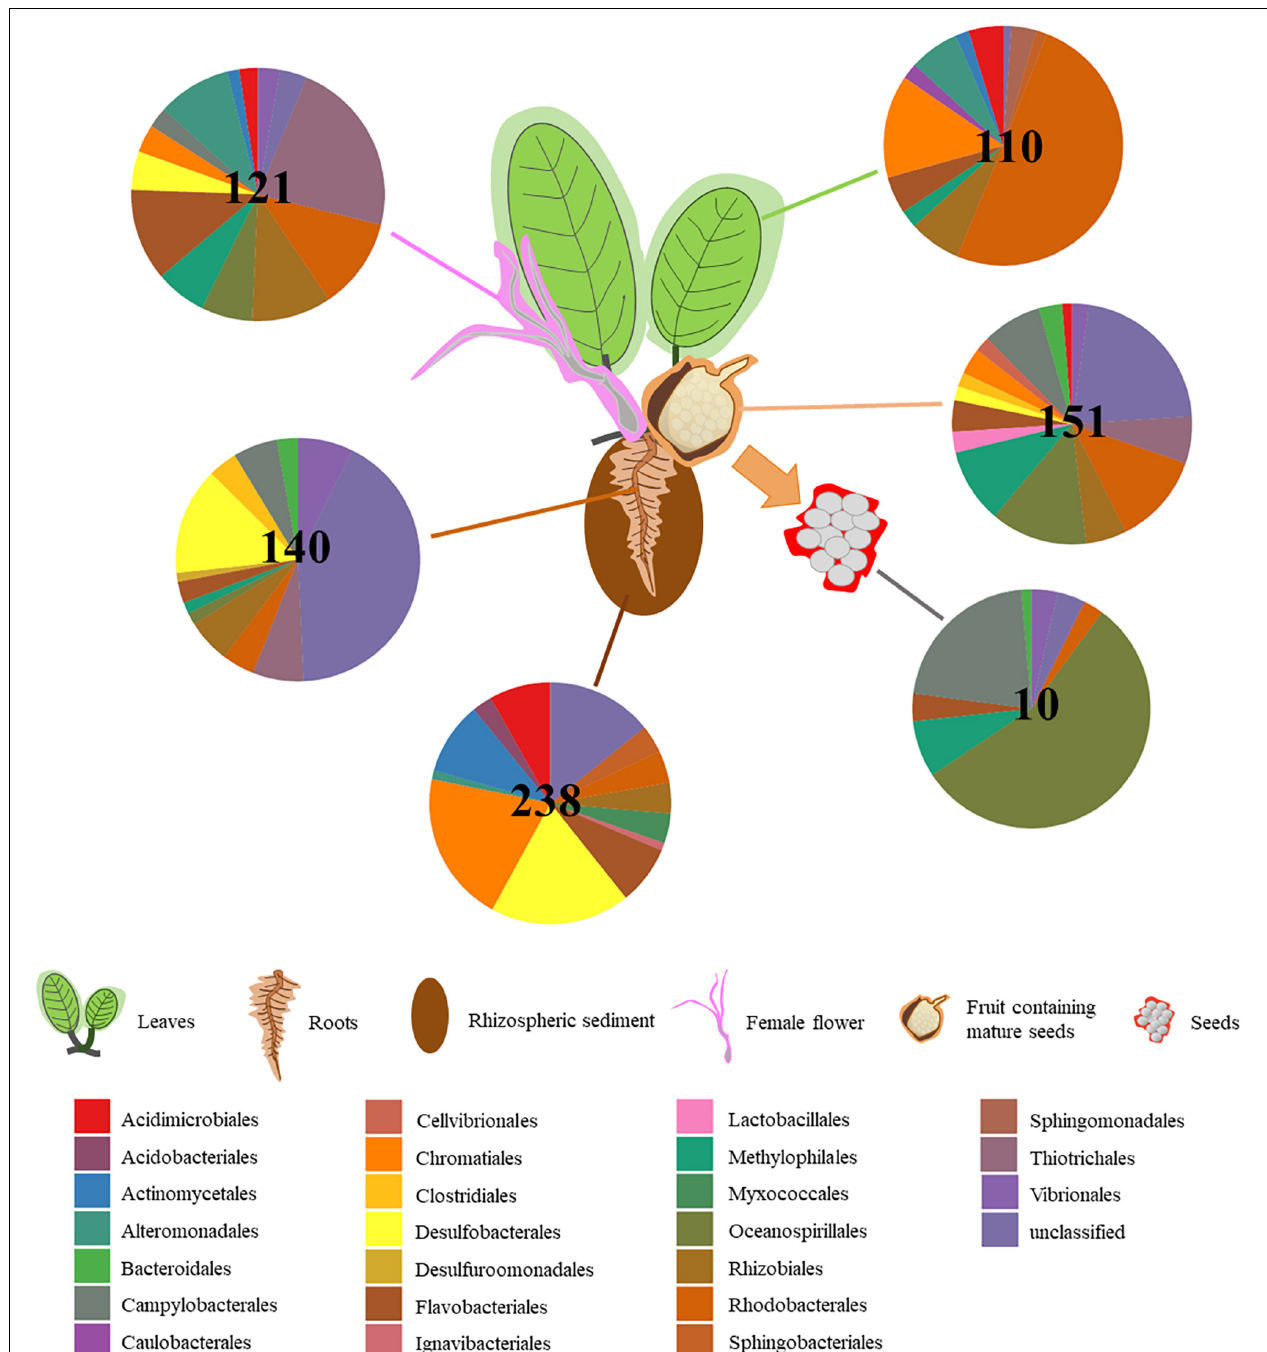
FIGURE 3 | Core microbiome composition varies depending on H. ovalis microenvironment. Pie charts show the relative abundances of the major bacterial orders that are detected within the core microbiome of the rhizospheric sediment, rhizosphere, root, leaf, flower, fruit, and seed. Only orders that represented > 0.1% of the total population are included. In the centre of the pie charts is reported the number of OTUs present in the core microbiome of each